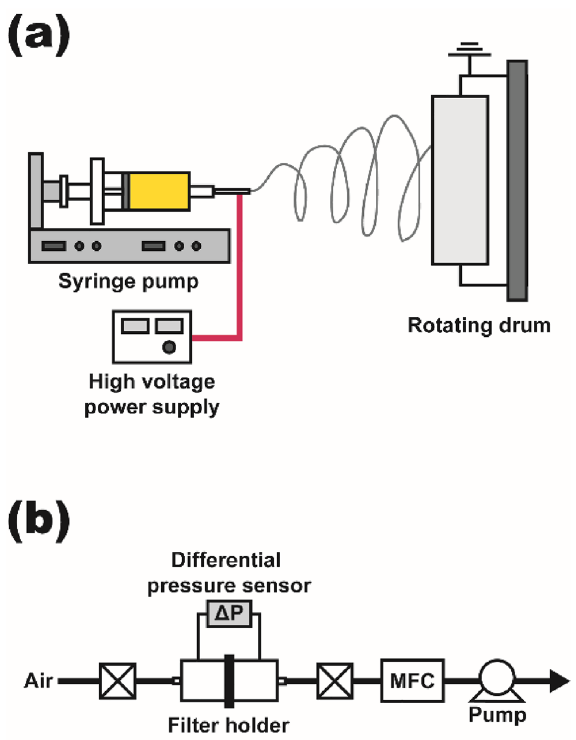
Figure 3. Schematics of the experimental setup for ( a ) fabrication of electrospun nanofibers and ( b ) pressure drop